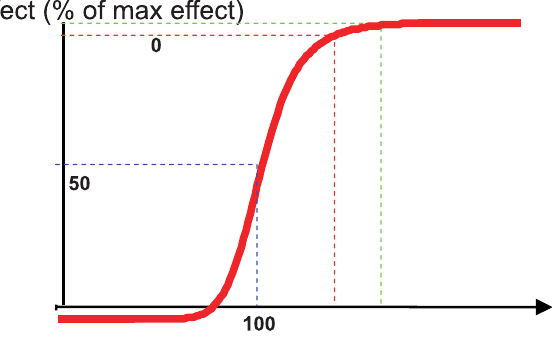
Figure 2. Concentration–effect sigmoidal E